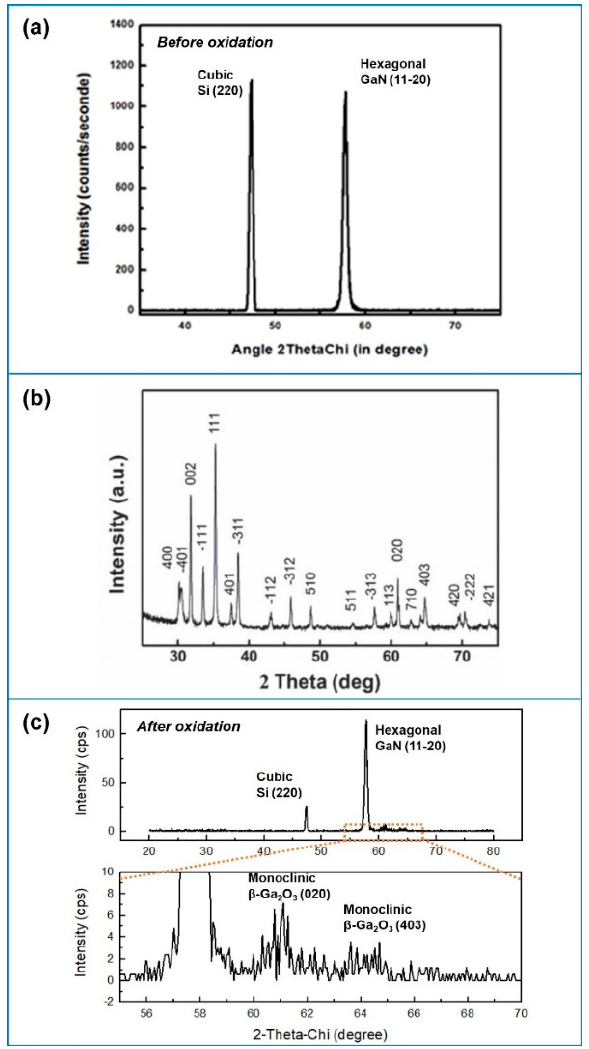
Figure 4. XRD analyses using in-plane Phi / 2ThetaChi scan configuration. ( a ) XRD spectra of as-grown GaN NWs before thermal oxidation; ( b ) Reference XRD spectrum of the β -Ga 2 O 3 in report [62] (Used with permission from JCPDS—International Centre for Di ff raction Data); ( c ) XRD spectra of GaN / Ga 2 O 3 NWs after oxidation at 900 ◦ C during 7 min under dry atmosphere with N 2 and O 2 fluxes of 5 sccm and 1.3 sccm,